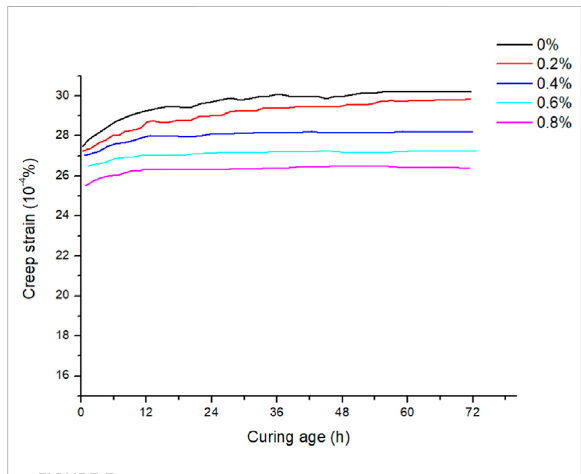
FIGURE 3 Effect of glass fi bre content on the creep value of cement